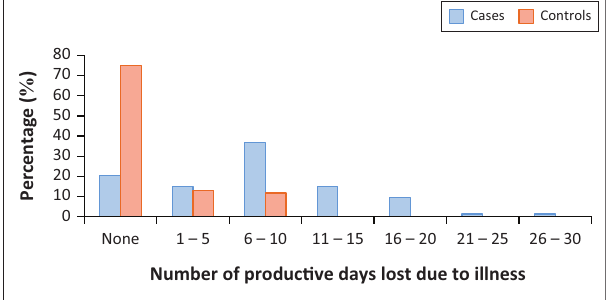
FIGURE 1: Average number of days spent without doing usual daily tasks because of sickness.